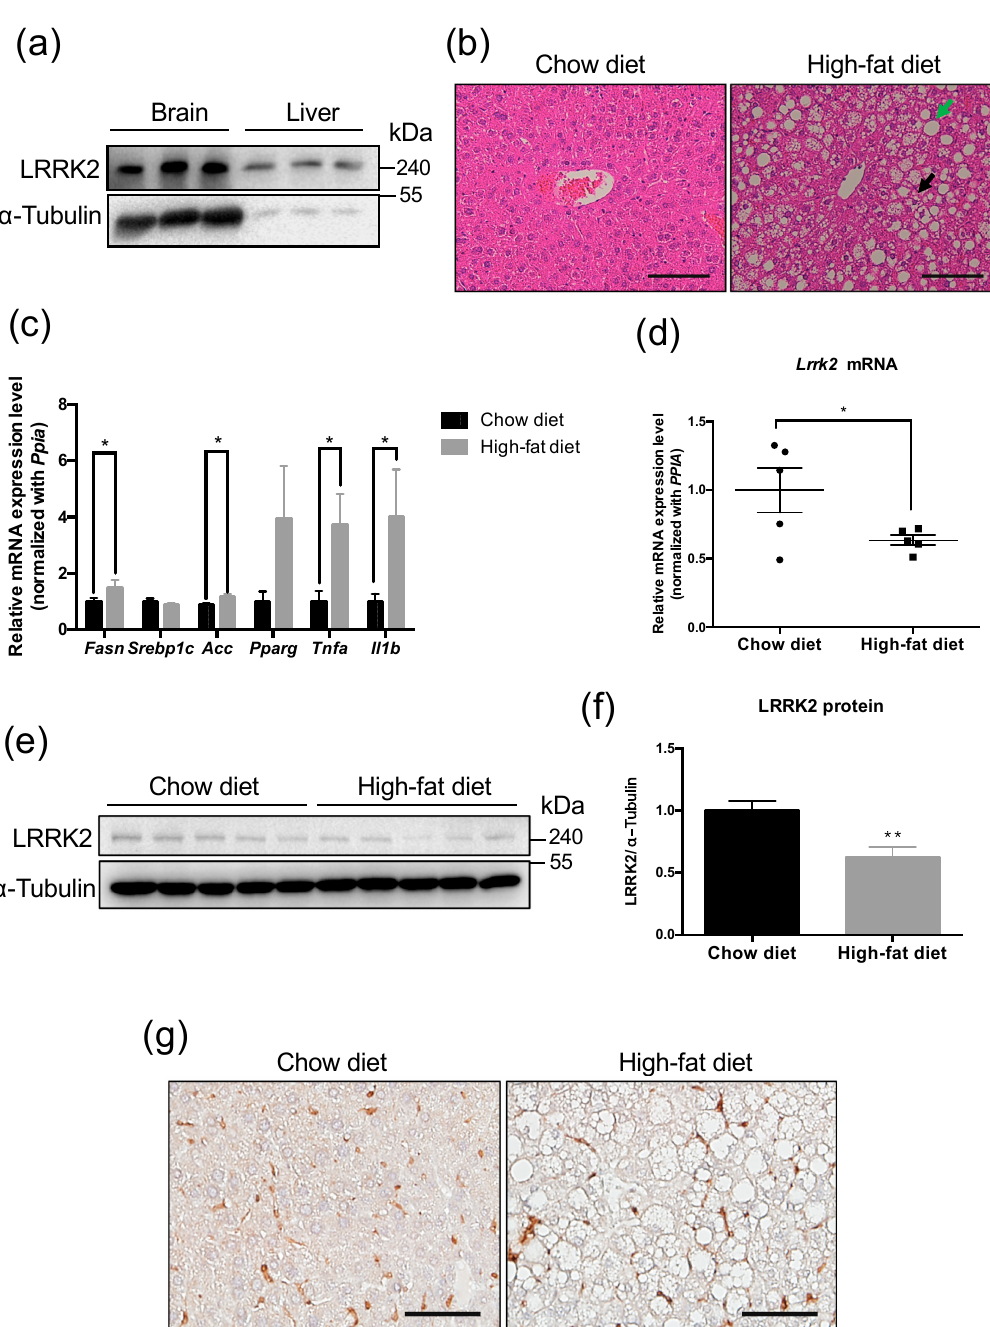
Figure 1. Leucine-rich repeat kinase 2 (LRRK2) was down-regulated in the liver of high-fat diet induced non-alcoholic fatty liver disease (NAFLD) mice. ( a ) A western blot was used to detect the presence of LRRK2 in an equal amount (25 μ g) of lysates from brains and livers. ( b ) Histological analysis of the livers in the mice fed with indicated diets by H&E staining. Green arrow indicates steatosis, and black arrow indicates hepatic ballooning. Scale bar = 50 μ m. ( c ) The lipogenesis related genes, Fasn , Srebp1c , Acc , and Pparg , and pro-inflammatory cytokine genes, Tnfa and Il1b , were analyzed in the livers of the mice fed with a chow diet or a high-fat diet using real-time PCR. ( d ) Relative levels of LRRK2 mRNA in the livers of chow diet and high-fat diet groups were analyzed by real-time PCR. ( e ) The protein expression of LRRK2 in the livers of chow diet and high-fat diet groups was analyzed by western blot. ( f ) The quantitative results of protein levels of LRRK2 in western blots. ( g ) IHC analysis of the livers in indicated groups using anti-LRRK2 antibody. Scale bar = 50 μ m. The quantitative data are shown as mean ± SEM ( n = 5 for each group). T-test, * p ≤ 0.05, ** p ≤ 0.01.